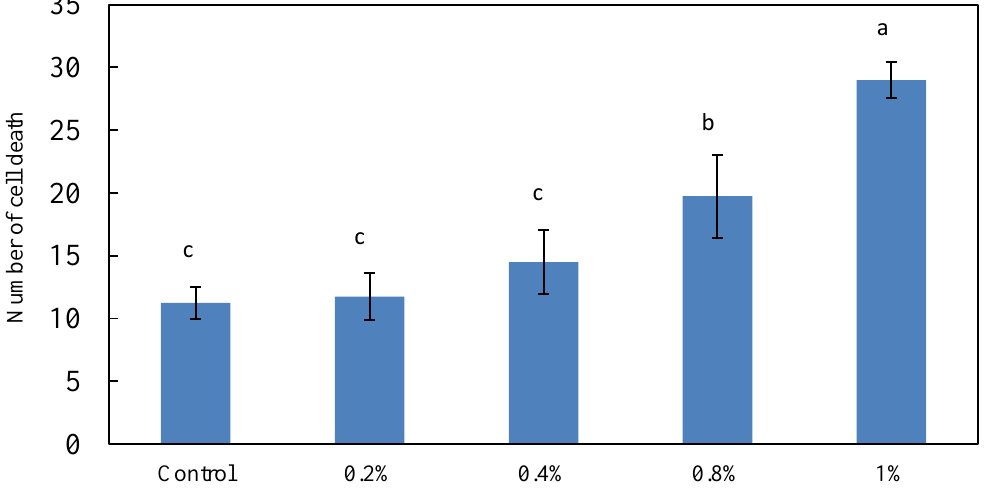
Figure 2. Effect of different ethanol concentrations on the brain cell death of zebrafish embryos. Twenty-four dpf zebrafish were exposed to different concentrations of ethanol for 24 h, except the control. The bar graphs represent the mean number of acridine orange-labeled cells, mean ± S.D.; n = 4 embryos. a–c The mean dead cell values with different letters are significantly different ( p < 0.05).